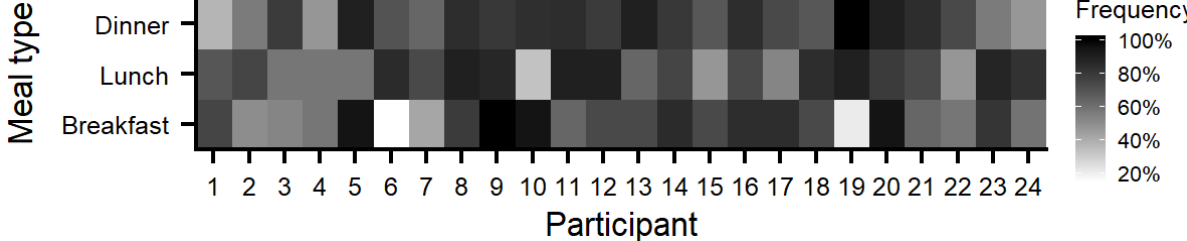
Population Food Selection